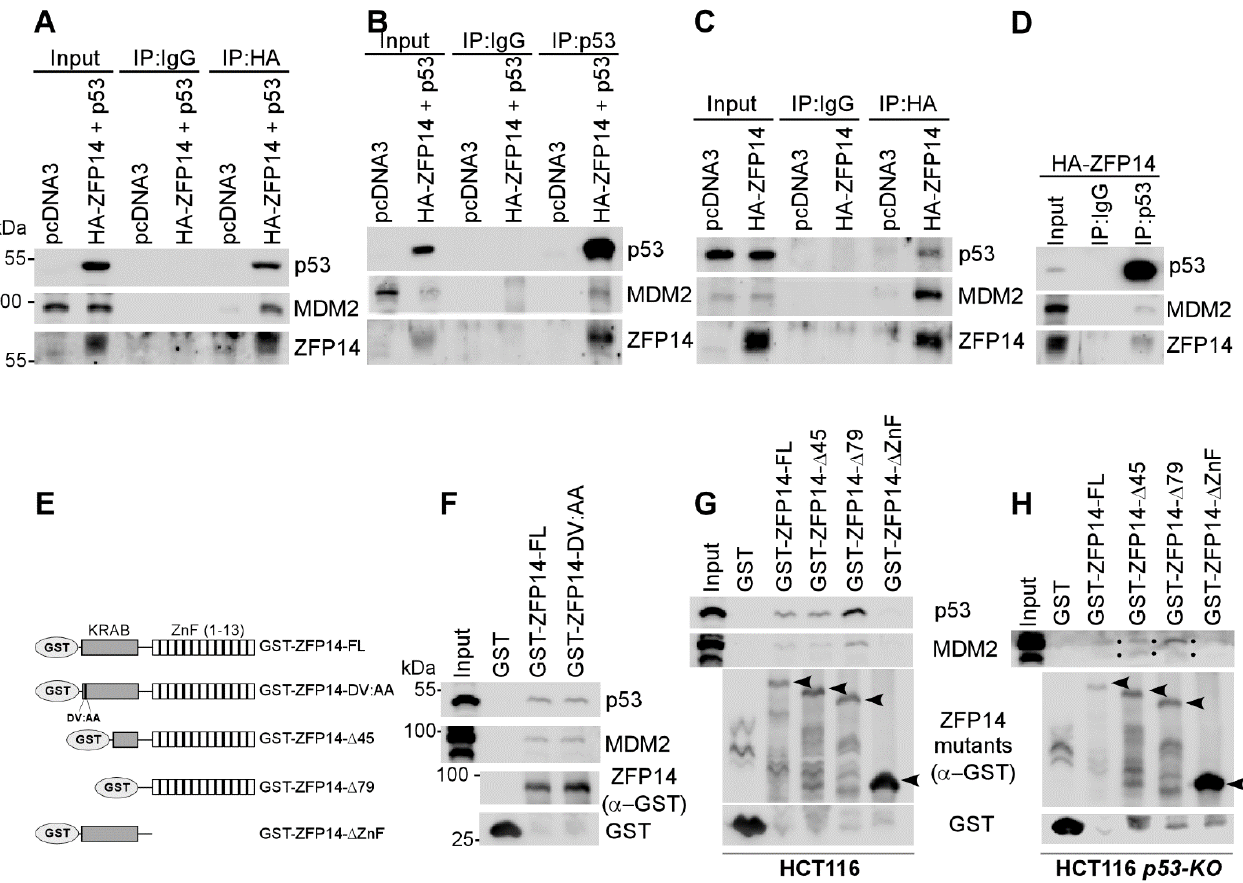
Figure 4. ZFP14 associates with MDM2-p53 complex via its zinc finger domains. ( A – D ) Lysates from HCT116 cells transfected with indicated plasmids were subjected to immunoprecipitation using anti-HA ( A , C ) or anti-p53 ( B , D ) antibodies. The immunoprecipitates were subjected to Western blotting to measure the association of p53, ZFP14 and MDM2 proteins. ( E ) Schematic diagrams and names of all of the GST-fused mutants of ZFP14 used for GST pull-down assays. The DV residues correspond to amino acids 10 and 11, respectively, in human ZFP14. ( F , G ) GST pull-down assays were performed by incubating the indicated bacterially purified GST-fusion proteins with HCT116 cell lysates followed by washes and Western blotting using the indicated antibodies. ( H ) GST pull-down assays were performed by incubating the indicated bacterially purified GST-fusion proteins with HCT116 ‐ p53 ‐ KO cell lysates followed by washes and Western blotting using the indicated antibodies.